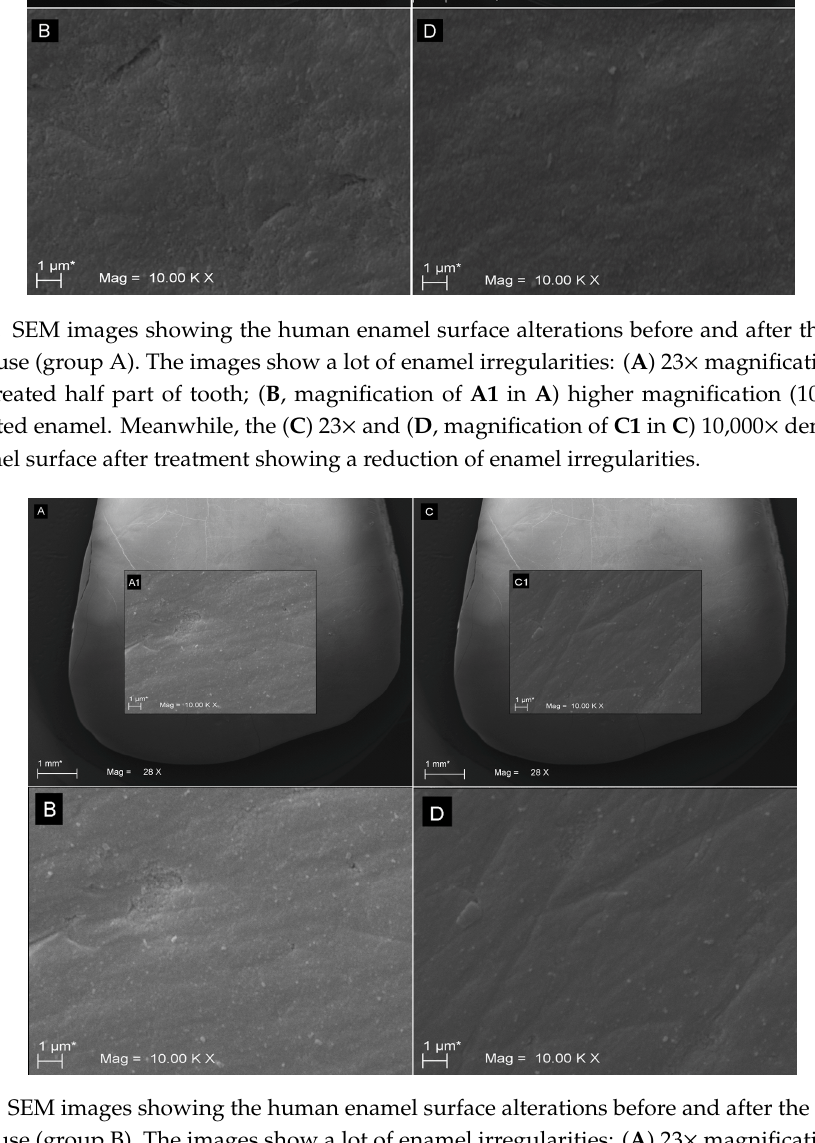
Figure 3. SEM images showing the human enamel surface alterations before and after the bicarbonate powder use (group C). The images show numerous enamel irregularities: ( A ) 23× magnification image of non-treated half part of tooth; ( B , magnification of A1 in A ) higher magnification (10,000×) of non- treated enamel. Pronounced depressions were present on enamel specimens. Meanwhile, the ( C ) 23× and ( D , magnification of C1 in C ) 10,000× demonstrate the enamel surface after treatment showing a